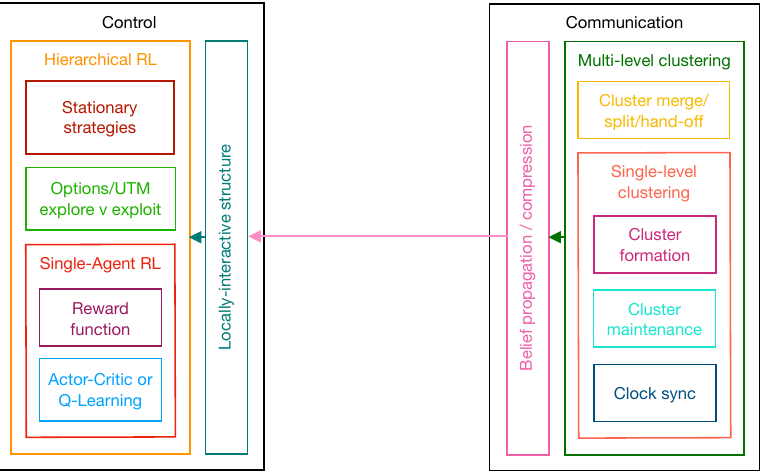
Figure 8. A proposed control and communication architecture for multi-agent tracking